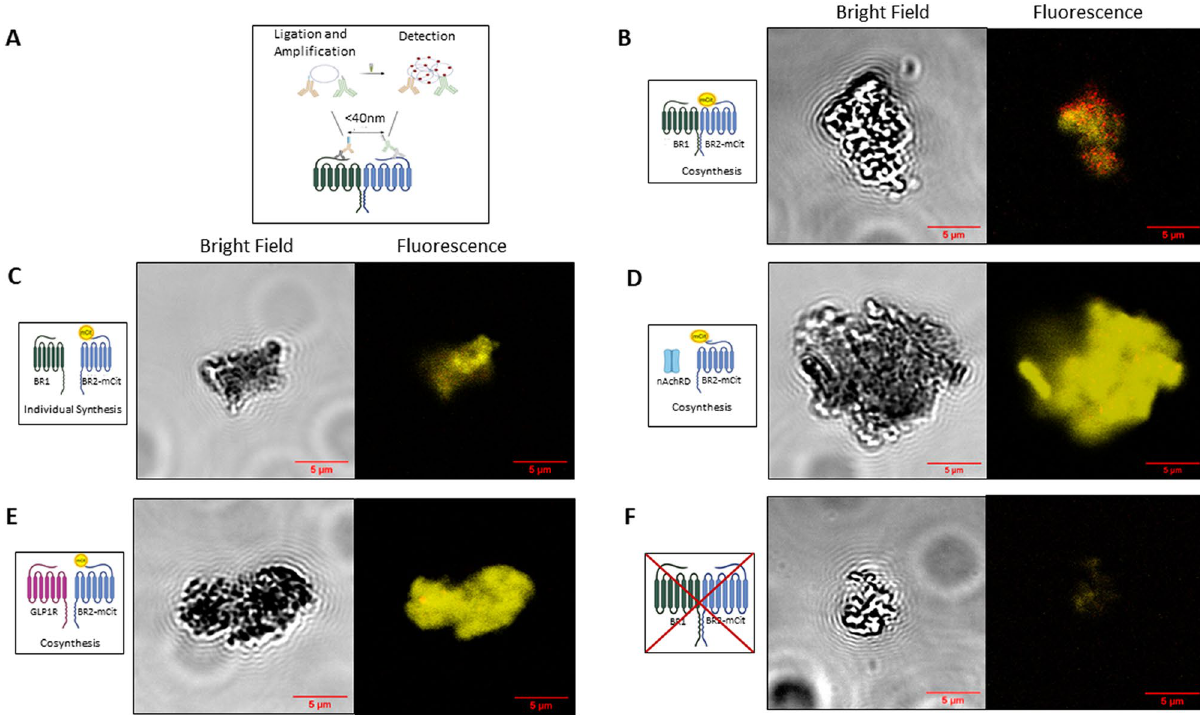
Figure 2. Detection of colocalized GABA B by a proximity ligation assay (PLA): Samples were incubated with primary antibodies and secondary probes, ligated and amplified. The red fluorescent PLA signal corresponds to spatial proximity, while BR2-mCit alone emits yellow fluorescence. Analysis was performed by a confocal laser scanning microscope. ( A ) Conceptualization of PLA using Merck Duolink PLA Kit. ( B ) Representative coexpression of BR1 and BR2 to detect heterodimeric assembly. Primary antibodies were previously validated (Fig. 1d,e). ( C ) Negative control: Separate CFPS of BR1 and BR2-mCit translocated into different microsomes. Primary antibodies were targeting BR2 and the fused His-tag of the nicotinic acetylcholine receptor subunit delta (nAChRd). ( D ) Negative control: Coexpression of nAchRd with BR2-mCit. Primary antibodies were targeting the nAchRd His-Tag and BR2-mCit. ( E ) Negative Control: Coexpression of glucagon-like peptide 1 receptor (GLP1R) with BR2-mCit. Primary antibodies were directed against the GLP1R His-Tag and BR2-mCit. ( F ) Negative control: CFPS approach without coding DNA-templates. Primary antibodies were previously validated (Fig. tary Fig. 3a). The addition of a luciferase substrate (furimazine) oxidizes the nanoluciferase and the energy is transferred to the fluorescent BR2-mCit. Once donor and acceptor molecules are below 10 nm apart, the energy is transferred via nonradiative dipole–dipole interaction, resulting in a light signal corresponding to the emis- sion of the acceptor (Fig. 3a) 33 . Saturation assays are most prevalent for studying oligomerization of GPCRs 34 , especially if oligomerization is not externally inducible. Therefore, a BRET saturation assay was performed with a fixed amount of BR1-NLuc coding plasmid coexpressed with increasing BR2-mCit plasmid concentrations. Coexpression of the labeled constructs showed fluorescence,whereas CFPS of the unlabeled protein showed no fluorescence signal (Supplementary Fig. 3b-d). This setup was transferred to the BRET assay, where coexpression of BR2-mCit with the adeno-A2A receptor fused to a nanoluciferase (Adora-NLuc) resulted in a linear BRET ratio with increasing plasmid concentration. This negative control excluded the possibility that the BRET signal resulted only from colocalization of the proteins within the same microsomes or overexpression. Instead, the BRET ratio curve of coexpressed BR1-NLuc and BR2-mCit showed a hyperbolic shape with a saturation level. These results indicate that the donor molecules of BR1 interact with the proximate BR2 molecules and thus form a heterooligomer. They confirm the previous PLA results and suggest a heterodimeric arrangement of the GABA B subunits in a eukaryotic CFPS system based on Sf 21 cells. To further demonstrate suitability of the synthesis and pharmacological screening of a heterodimeric GPCR, we performed a fluorescence based antagonist binding study (Fig. 3c). The orthosteric antagonist (CGP 54626A) binds to the target protein specifically in its VFT region 3 . A strong fluorescence signal for the antagonist binding to the sample is detectable, while negative control without coding DNA plasmid, showed a much weaker fluores- cence signal. The overall high background of the experiment is due to the lipophilic character of the antagonist, which appears to interact slightly with the microsomal membrane. The suitability of cell-free synthesized heter- odimeric GPCRs and their use for pharmacological applications have been demonstrated accordingly.